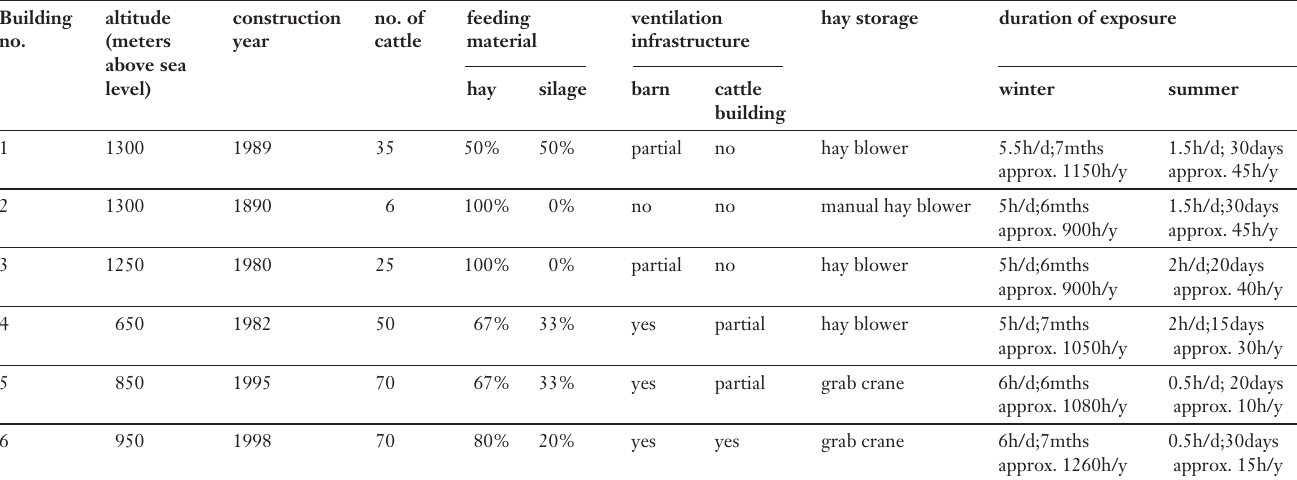
Characteristics of selected dairy farms.